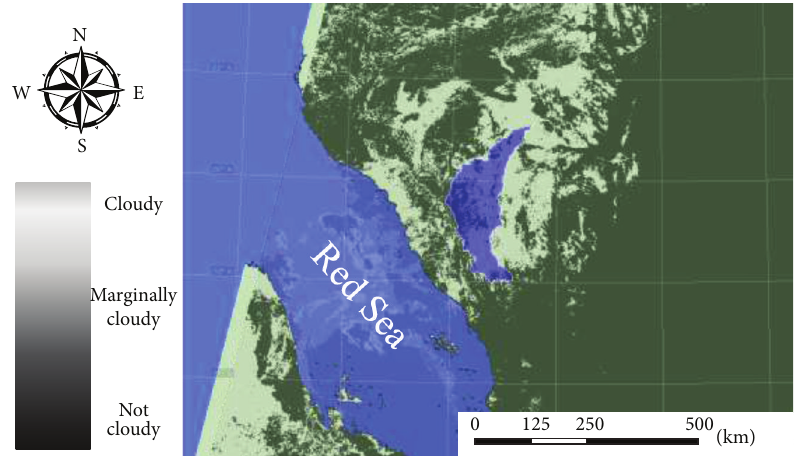
Figure 5: Cloud probability classes with watershed highlighted.